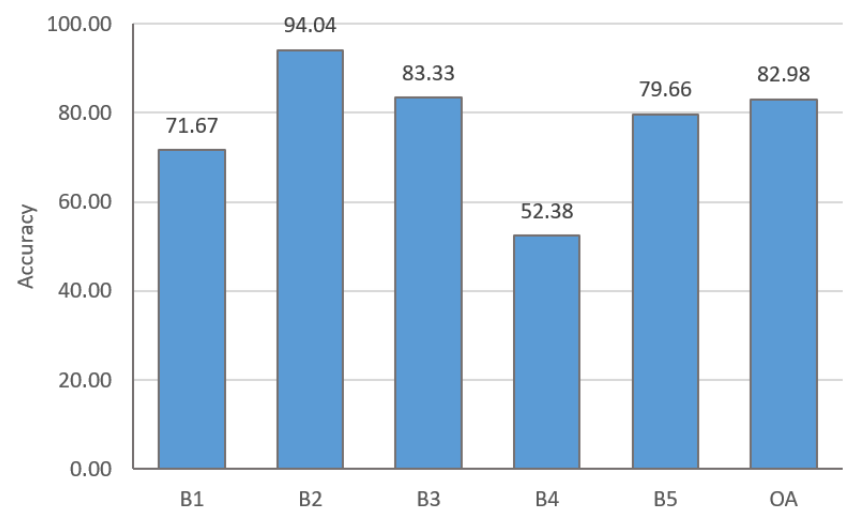
Figure 9. Classification accuracy of building types. B1~B5 stand for: intensive building, middle and